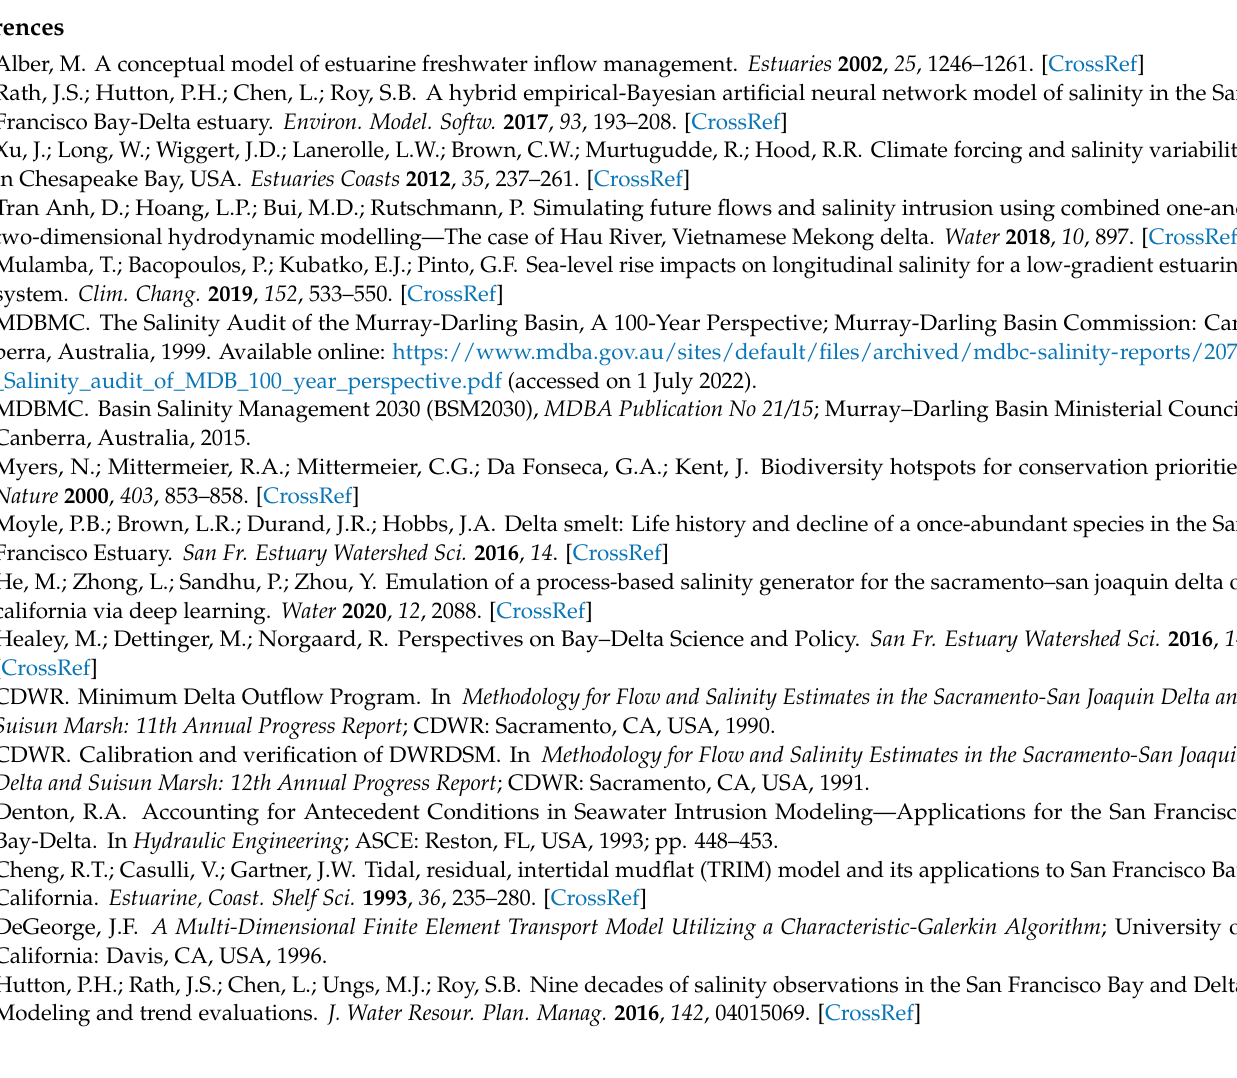
Figure A9. Time series plots of observed salinity levels versus Res-LSTM simulations and DSM2 simulations of the 23 stations. Detailed values of four evaluation metrics of Res-LSTM and DSM2 are marked for each